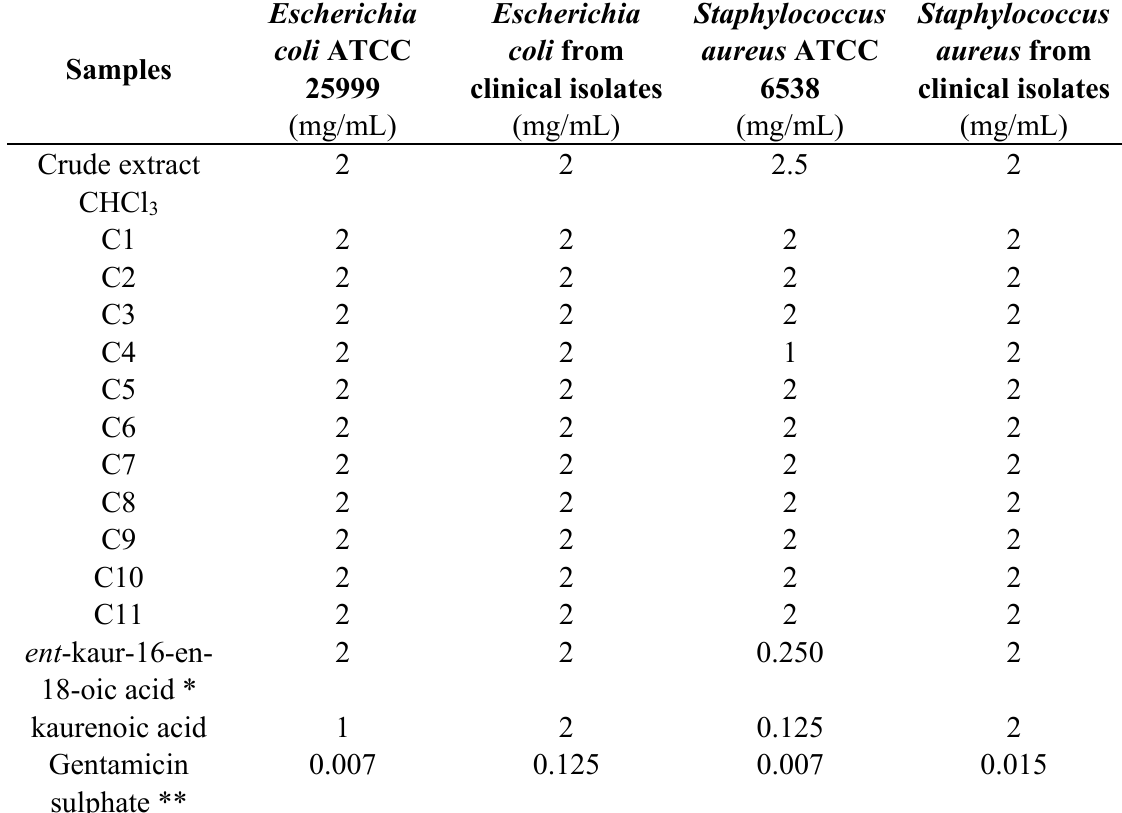
Table 2. Antimicrobial activity of extract, fractions and diterpene of C. antisyphiliticus .